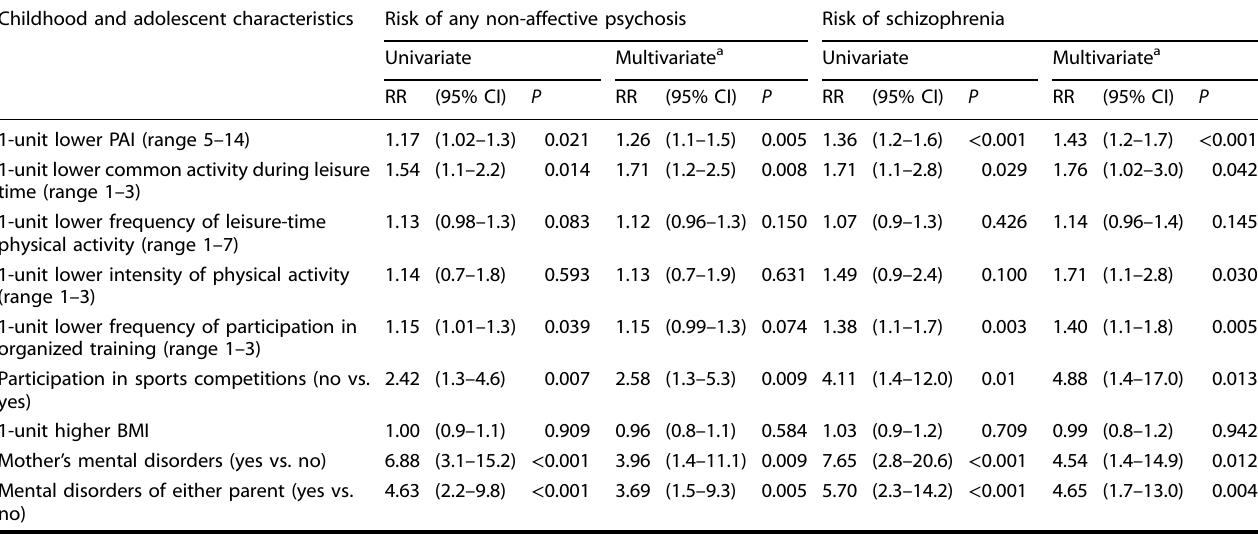
Table 2. Childhood and adolescent characteristics measured at the age of 9 – 18 and their associations with the risk of later development of any non- affective psychosis or schizophrenia in 1980 –